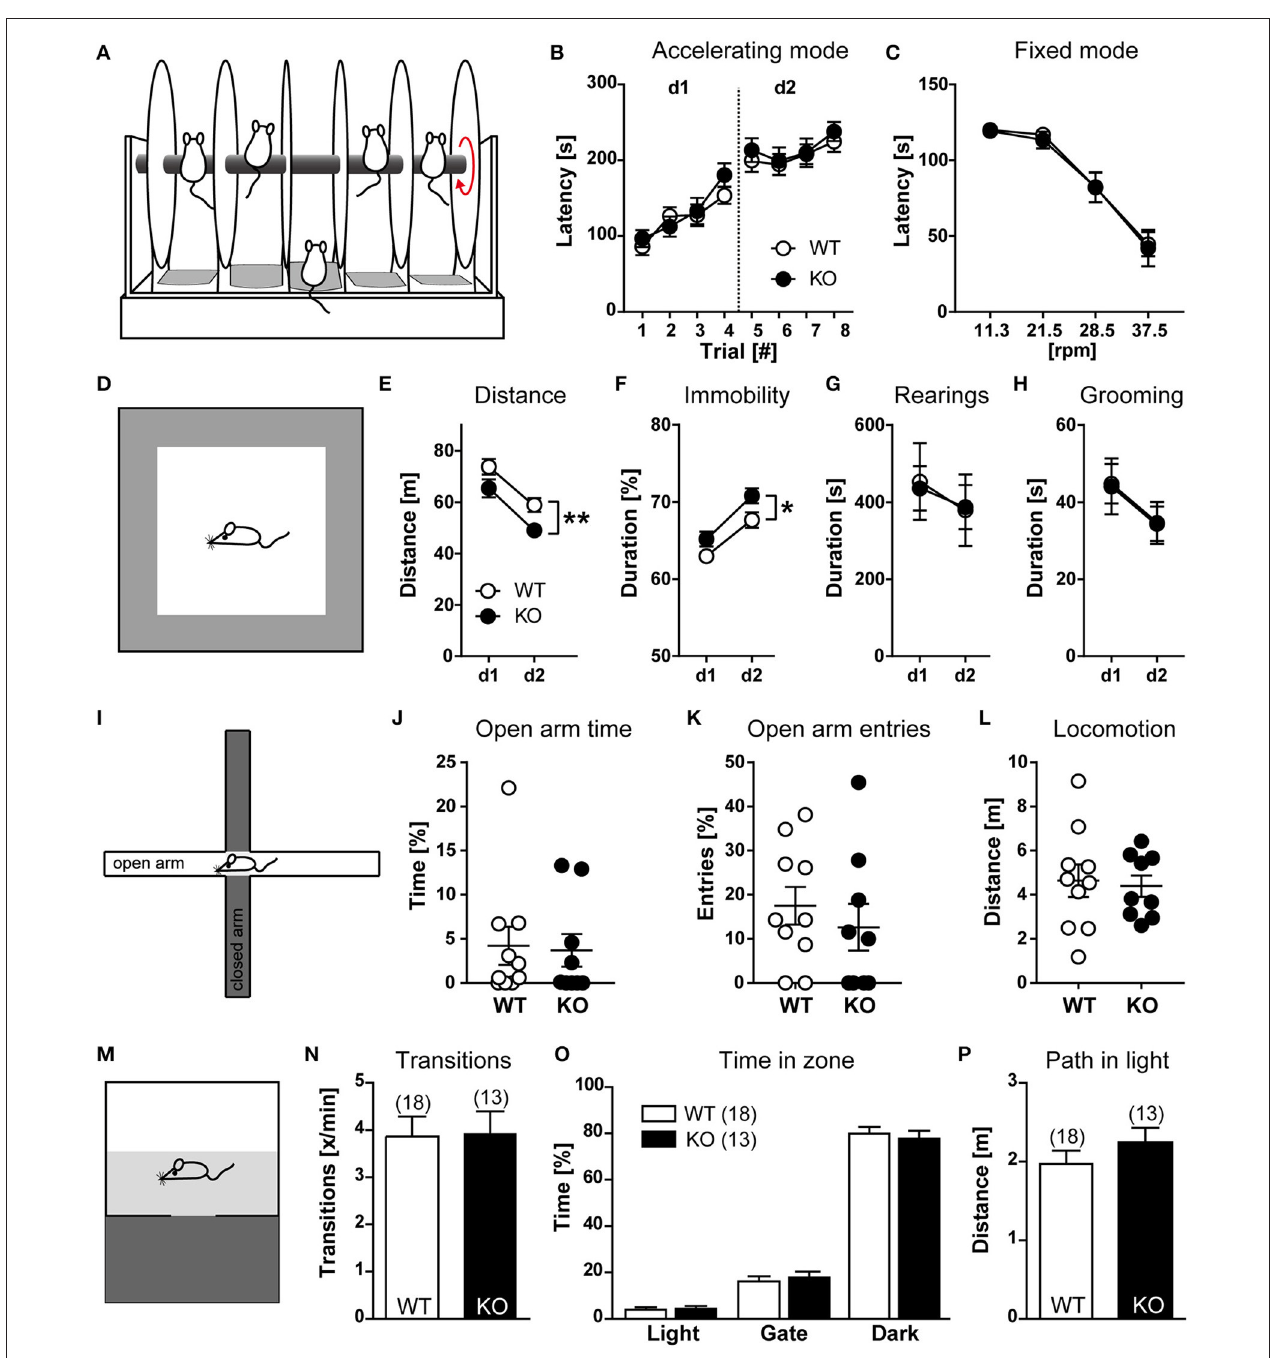
FIGURE 5 | Behavioral characterization of HCN3 − / − mice (part 1). (A) Schematic of the rotarod test. Mice were placed on drums rotating at an accelerating rotation speed (B) or at the rotation speed indicated (C) . The time at which an animal fell from the drum was measured. The increased latency from trial 1 to trial 8 indicates motor learning behavior (B) . (D) Schematic of the open field test. (E–H) Open field performance on two consecutive days. Monitoring of general locomotor activity in a novel environment over 10min. The distance traveled (E) , relative time of immobility (F) , rearings (G) , and grooming (H) are indicated. (I–L) Elevated plus maze. Schematic of the maze (I) . Analysis of time spent in open arms (J) , entries into open arms (K) , and total locomotion (L) revealed no genotype differences. (M) Schematic of the light-dark box. (N–P) In the light-dark box no genotype differences were evident since all animals showed the same number of transitions (N) , avoided the brightly illuminated part of the chamber (O) , and traveled a similar distance in the bright area (P) . All values are Mean ± SEM, * p < 0.05, ** p < 0.01.